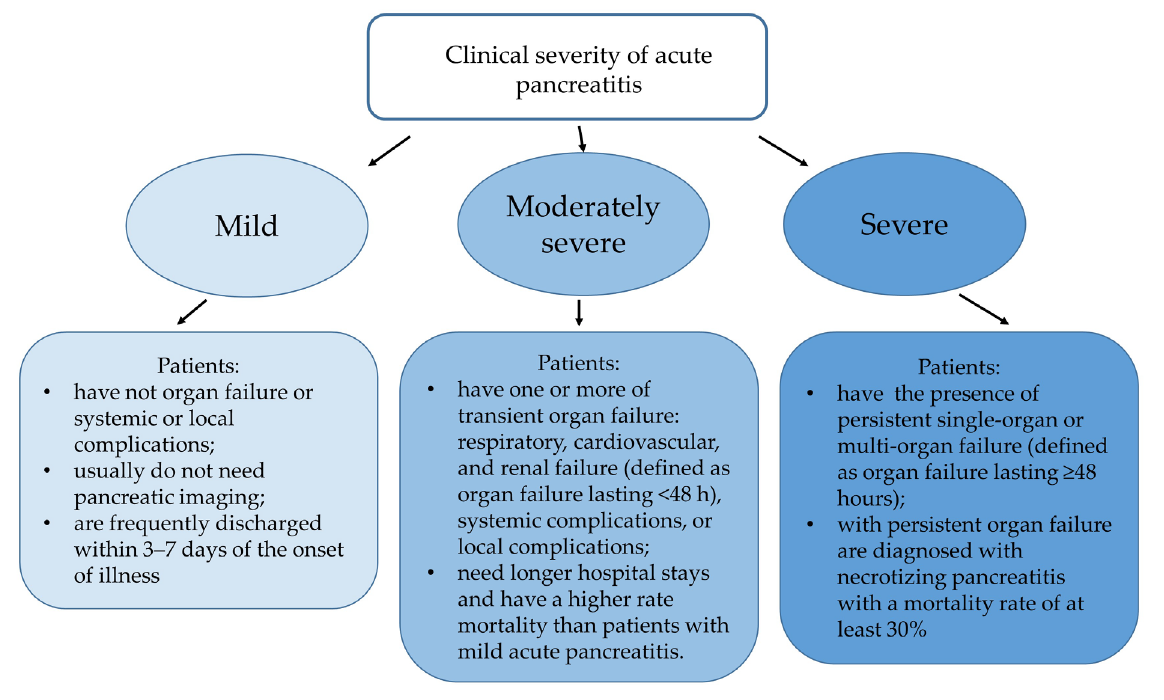
Figure 2. Clinical severity of acute pancreatitis [3].